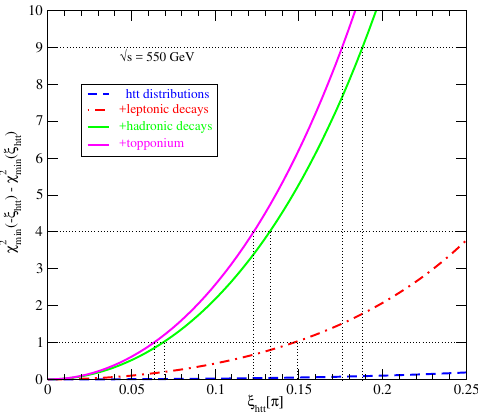
Figure 11 . The (cid:31) 2 plot at p s = 550 GeV assuming (cid:24) ex (cid:24) ex = (cid:25)= 4 as the observed data (right panel). htt